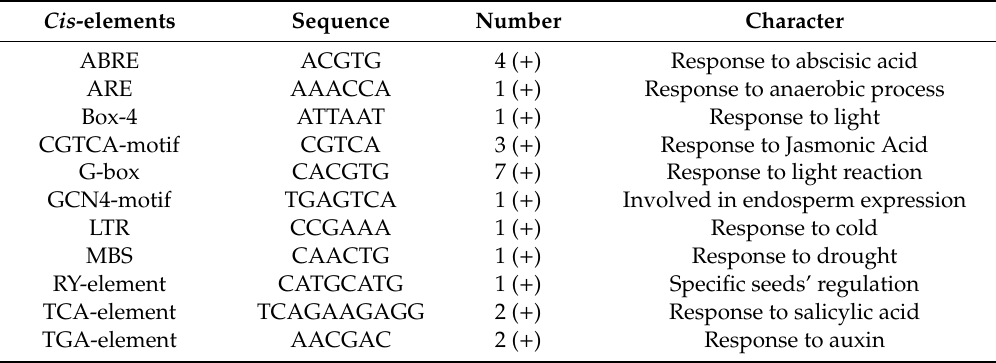
Table 1. Predicted cis -elements in the promoter of FaNAC2